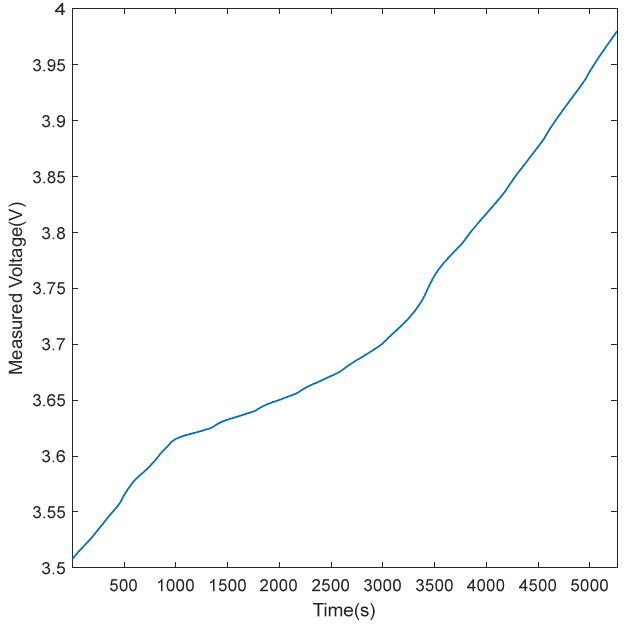
Figure 8. Measured voltage during low-current charging.